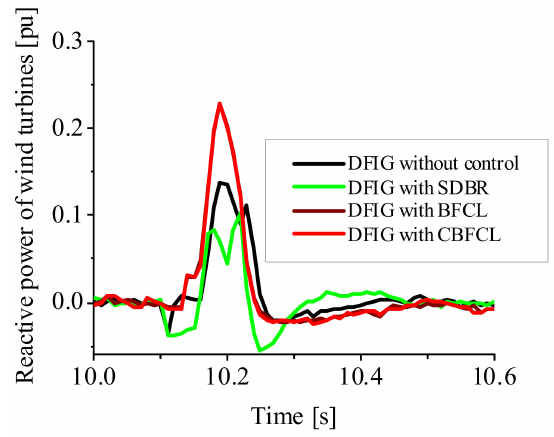
Figure 21. Reactive power of DFIG wind turbine.